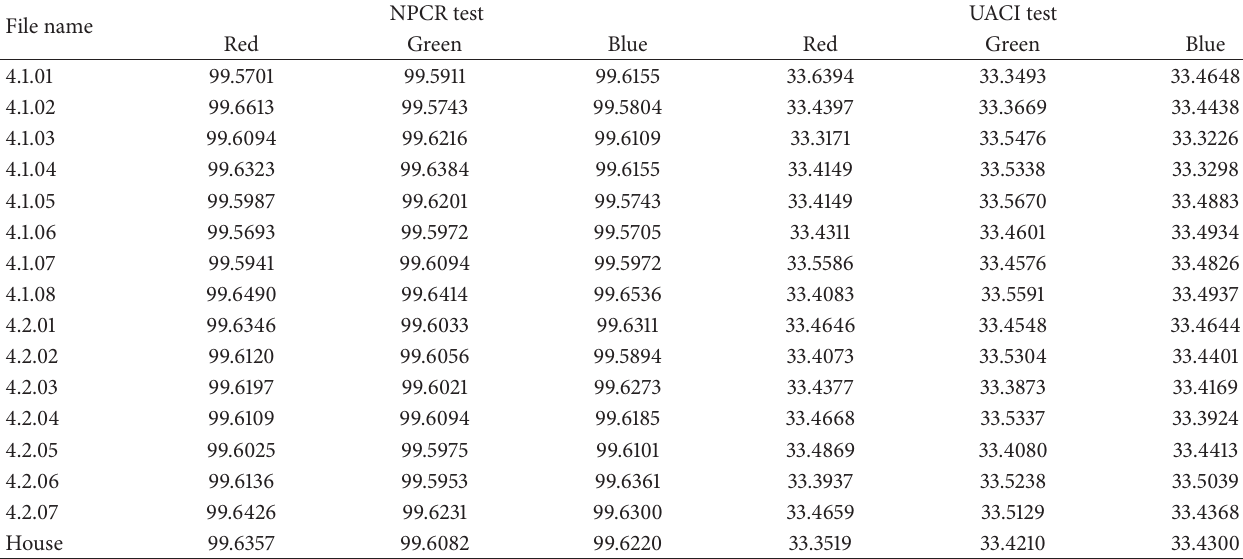
Table 7: NPCR and UACI results of encrypted plain images and encrypted with one pixel difference plane